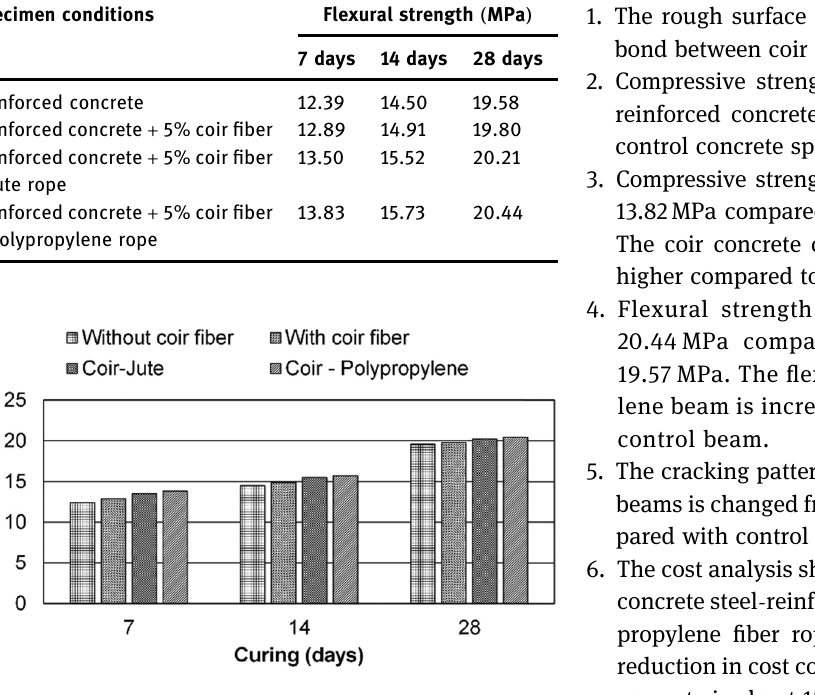
Figure 9: Flexural strength variation with curing